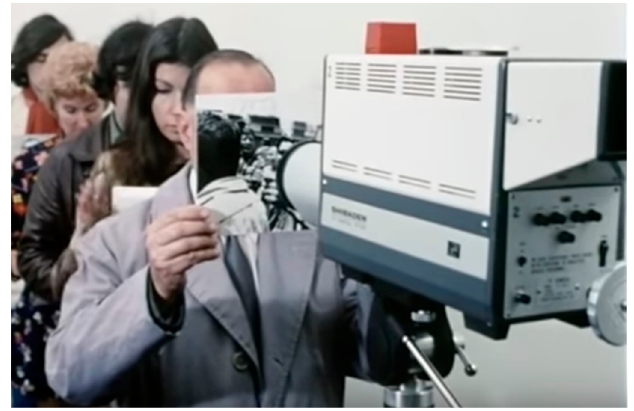
Figure 11. Still from Ici et ailleurs, dir. Jean ‐ Luc Godard and Anne ‐ Marie Miéville, 1976.